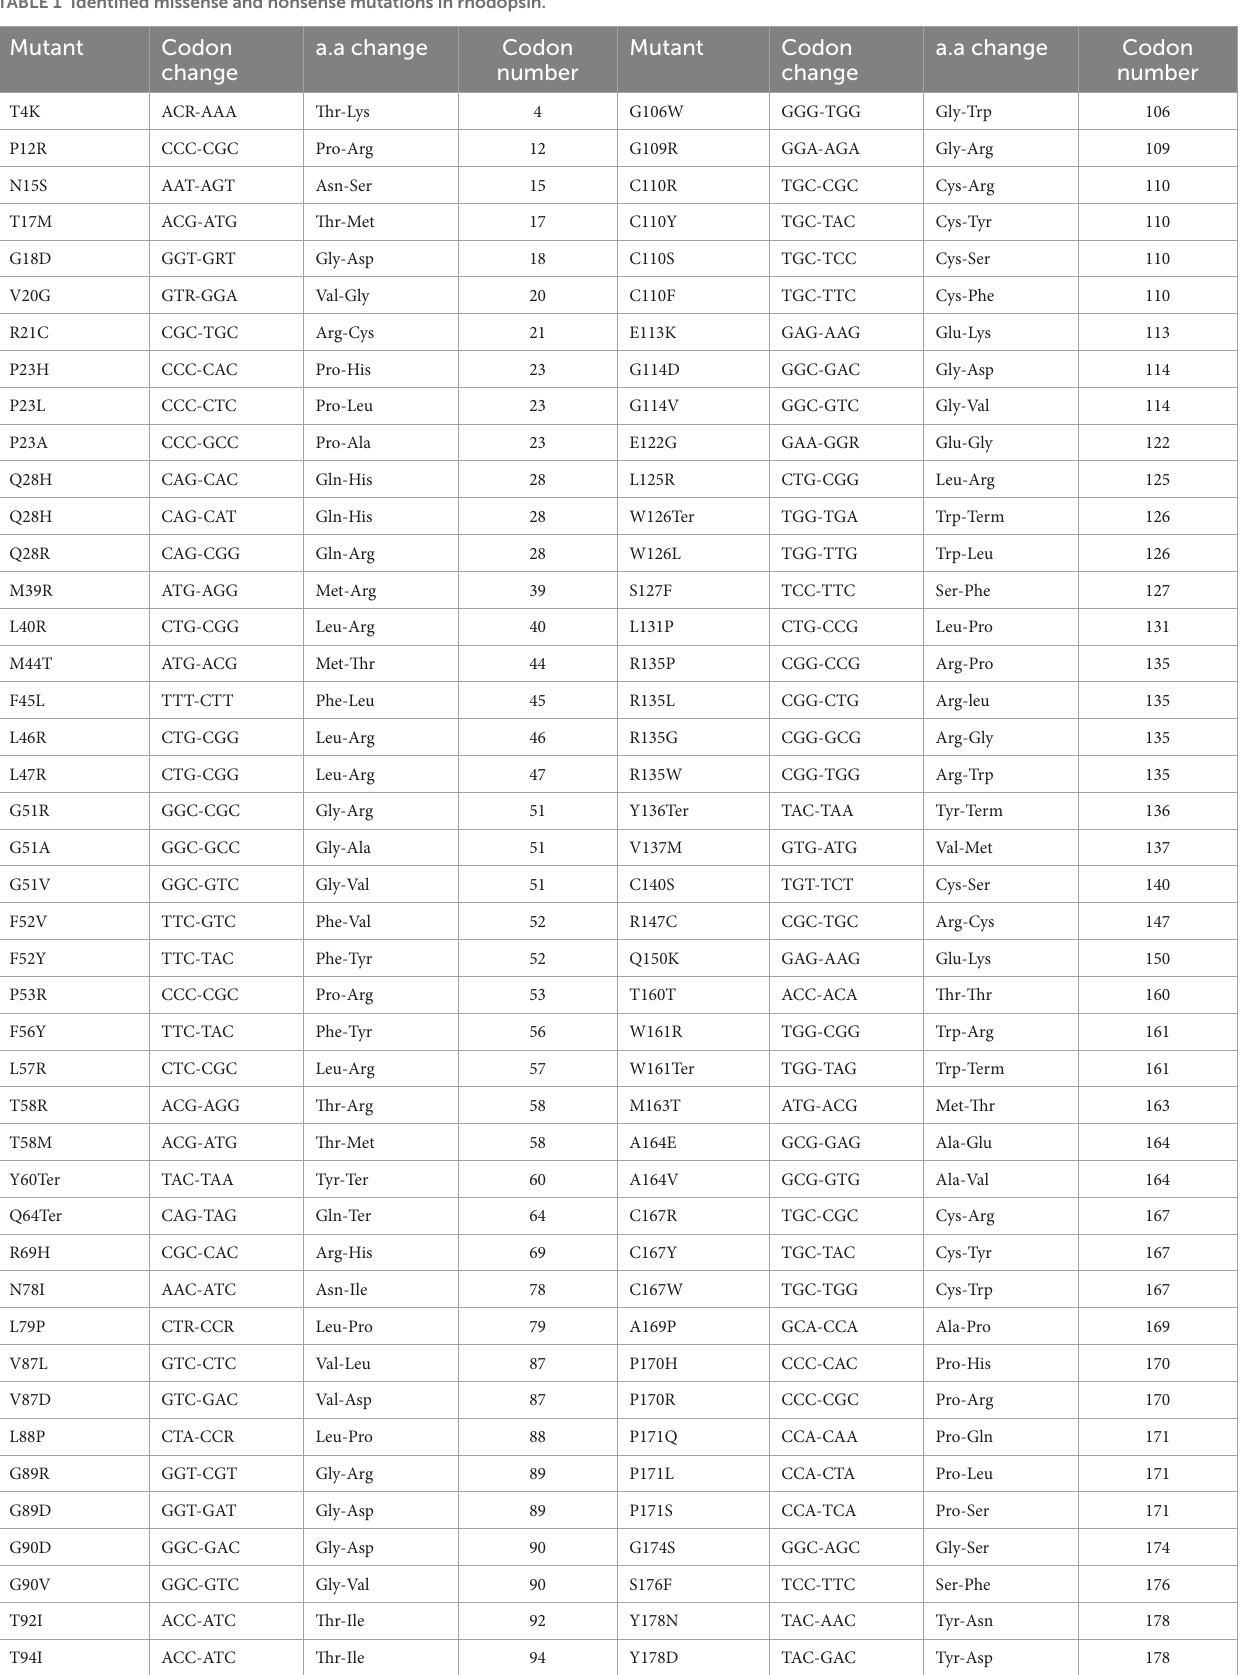
TABLE 1 Identified missense and nonsense mutations in